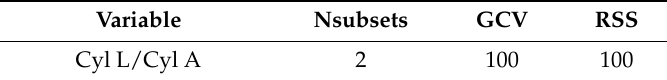
Table 8. List of basis functions of MARS model number two and their coefficients for feed into the